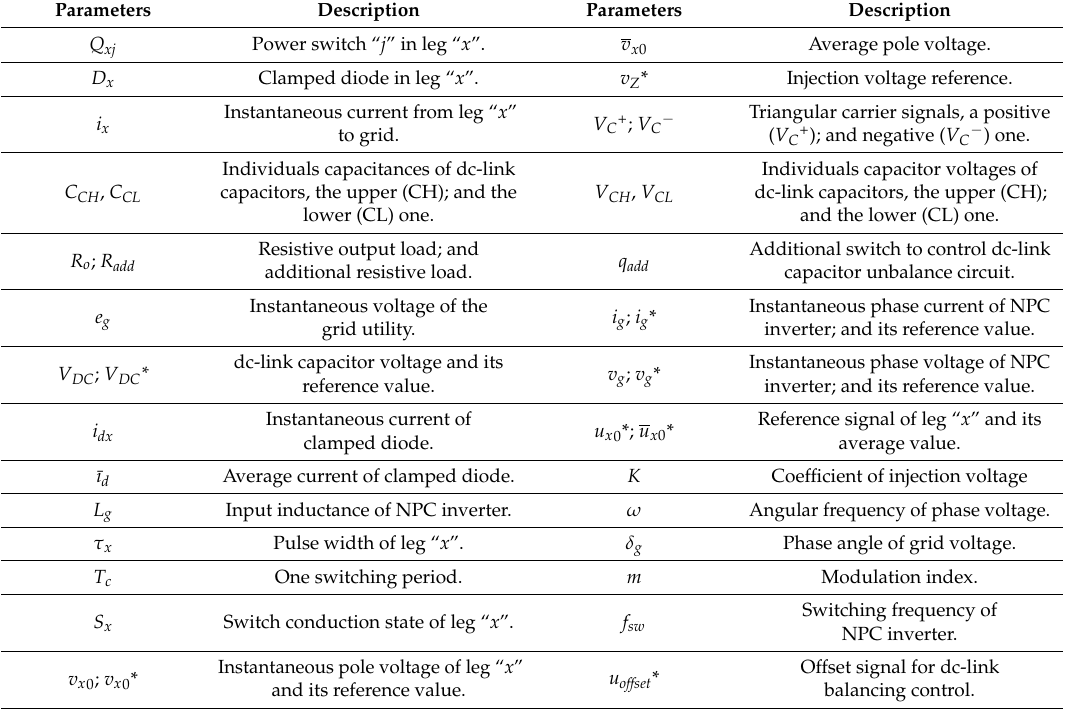
Table 1. Nomenclature of the hardware and controller parameters. Figure 1. The switching leg of the three-level neutral-point-clamped (NPC) inverter and its switching states. ( a ) The circuit structure; ( b ) the conduction state with S x = 1; ( c ) the conduction state with S x = 0; and ( d ) the conduction state with S x = − 1.